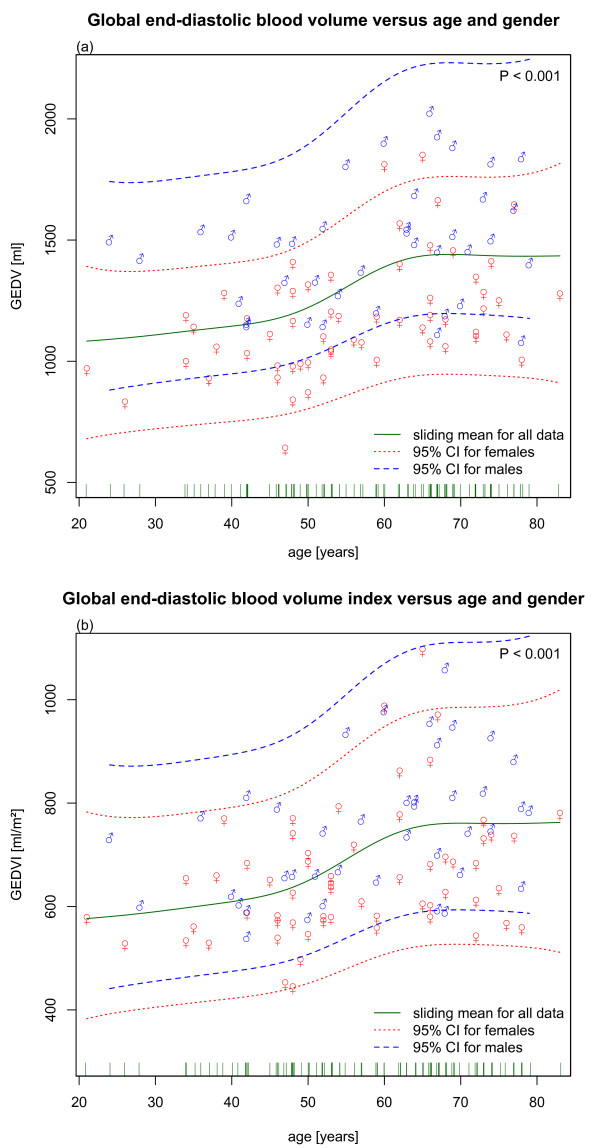
(a) Global end-diastolic volume (GEDV) and (b) global end-diastolic volume index (GEDVI) versus age using a generalized additive model. The continuous line represents the highly significant non-linear relationship for all data (P < 0.0001). The dotted and dashed lines show the 95% confidence interval (CI) for females and males. Single data points are shown with male and female symbols.